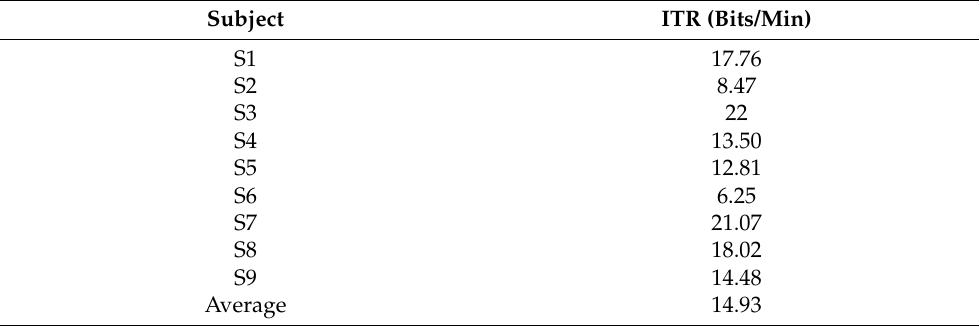
Table 5. ITR values for each subject in the BCI-IV2a dataset.